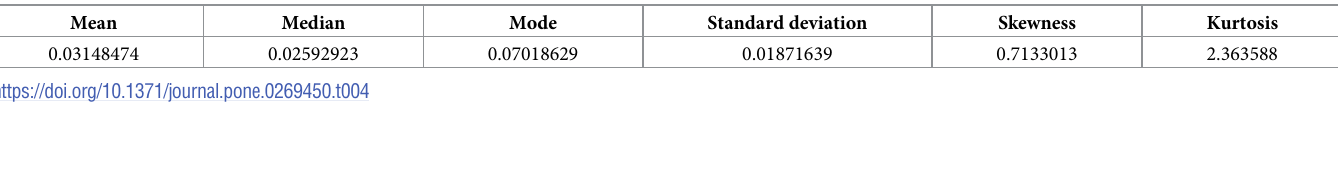
Table 4. Descriptive characteristic of the proposed